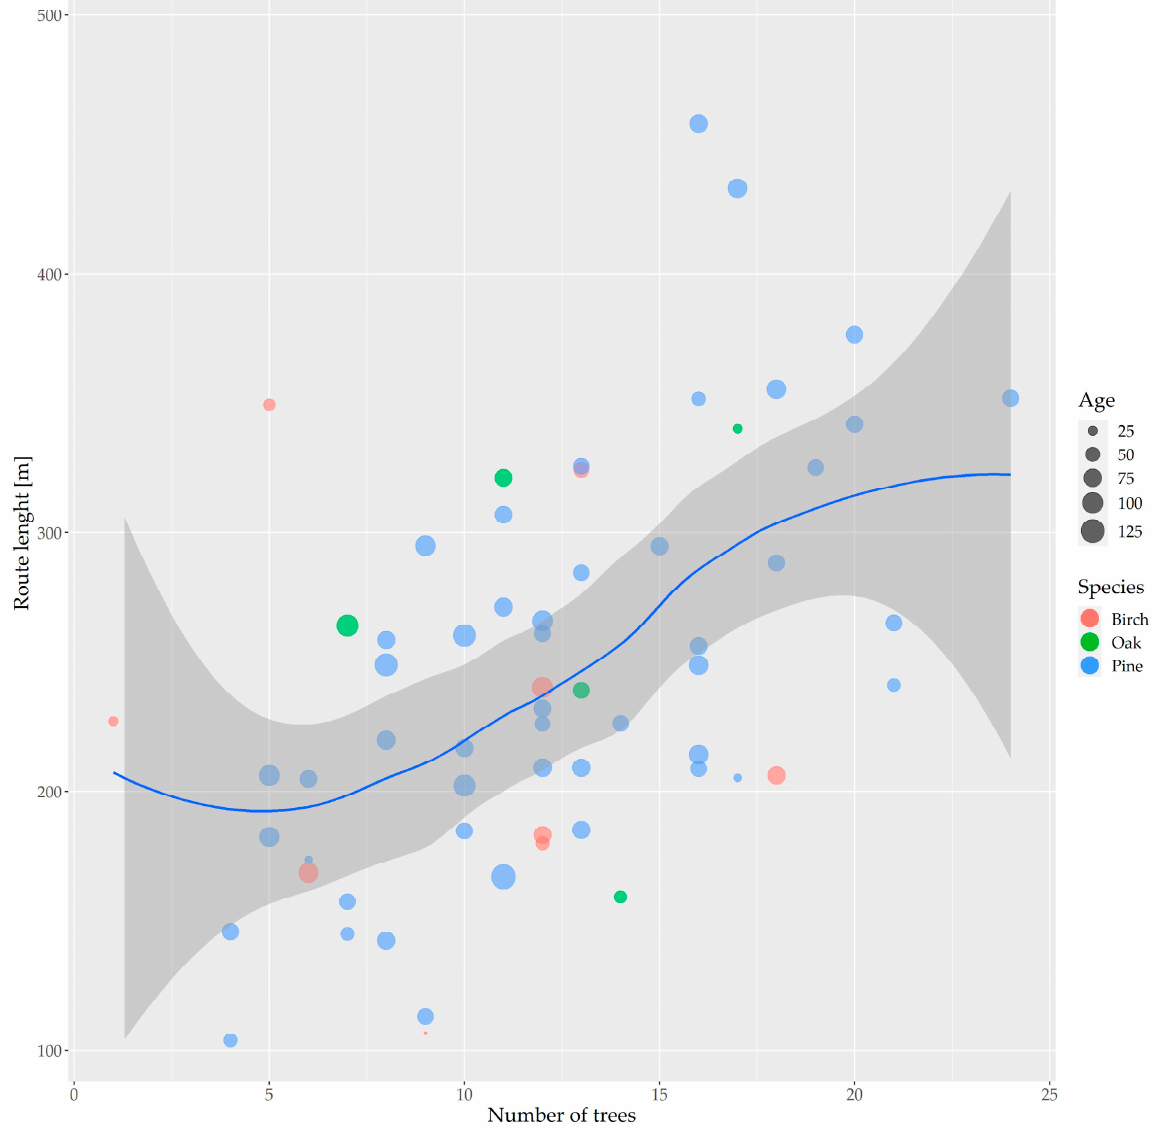
Figure 4. Dependence of the number of trees according to the route length with the scanner. The dot size presents the main tree species’ age, and the color indicates the species. Table 2. Comparison of errors taking into consideration the main tree species. Variable Pine Birch Oak